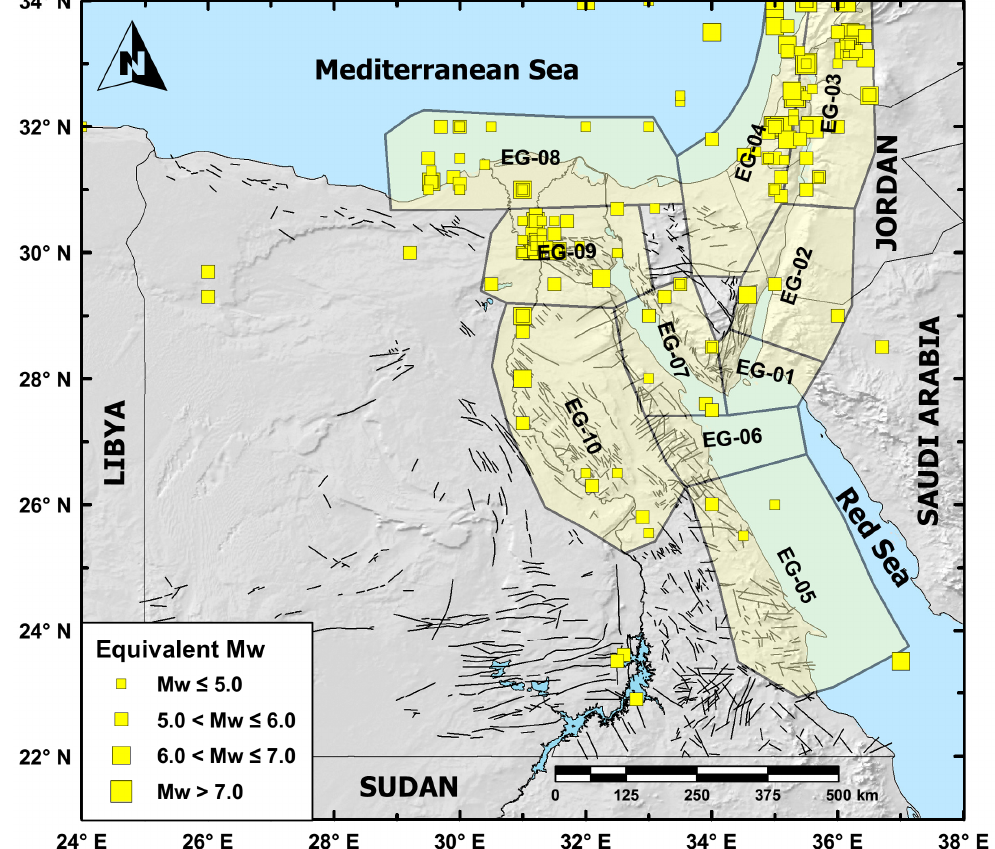
Figure 3. Historical earthquakes (2200 B.C.–1899 A.D.) of Egypt and its surroundings (after [48,61]). Black lines refer to EGSA [62]. Polygons labeled from EG-01 to EG-10 refer to the delimited seismic sources in the current work.